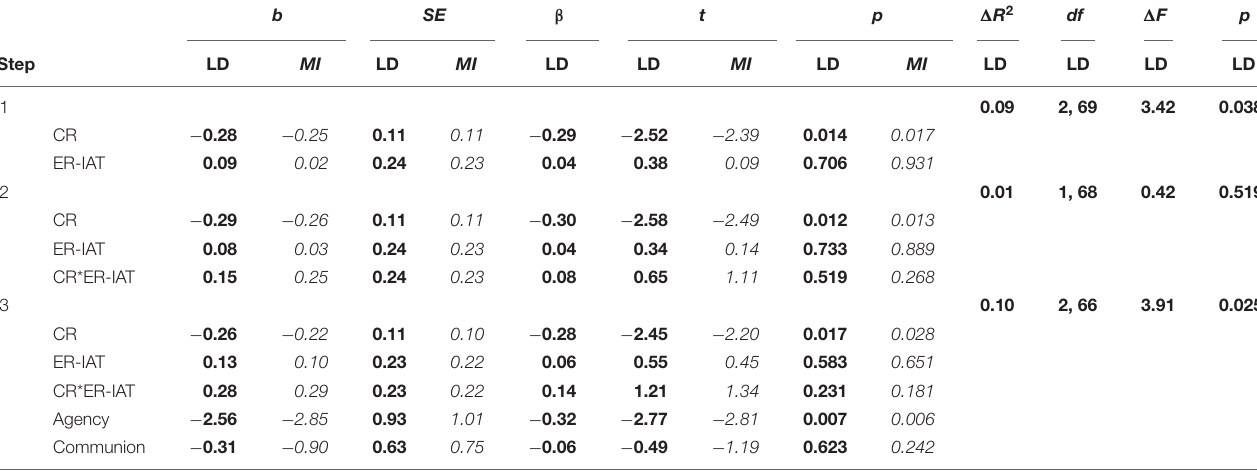
TABLE 7 | Results of the hierarchical multiple regressions for model 1b using LD and MI.